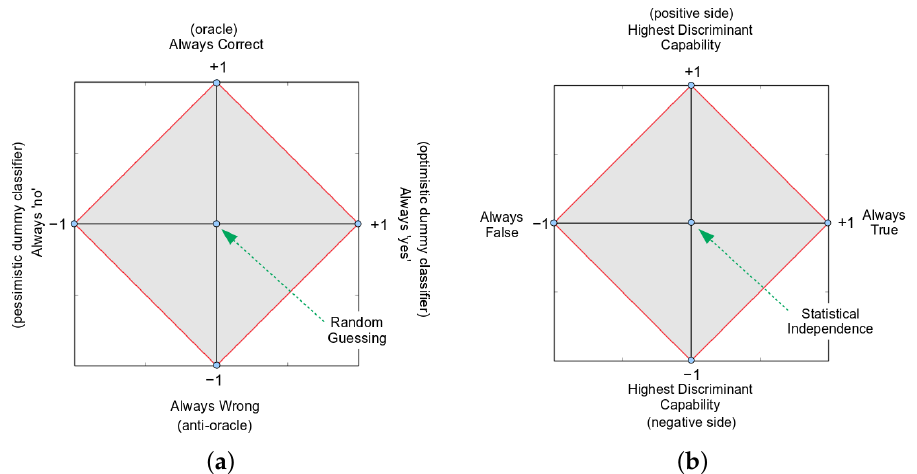
Figure 2. Semantics of (cid:104) ϕ , δ (cid:105) diagrams, applied to classifier performance measures ( a ) or feature im- portance assessment ( b ). The ϕ axis is on the abscissa, while the δ axis is on the ordinate. ( a ) Semantics for classifiers. ( b ) Semantics for feature